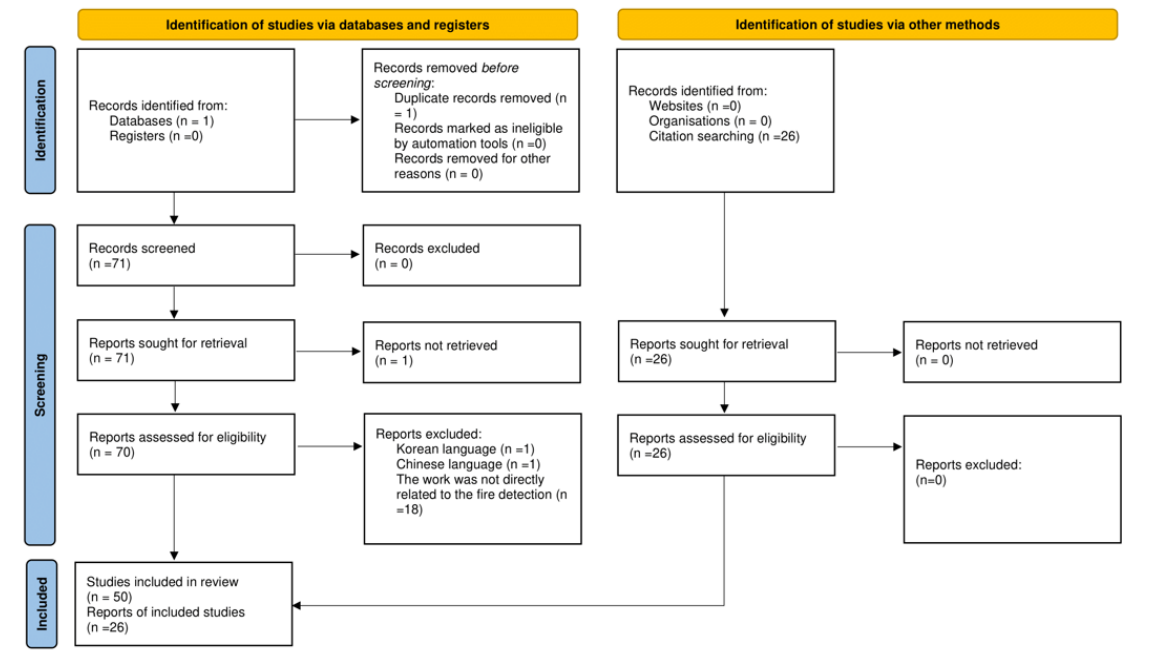
Figure 2. Adopted PRISMA flow diagram